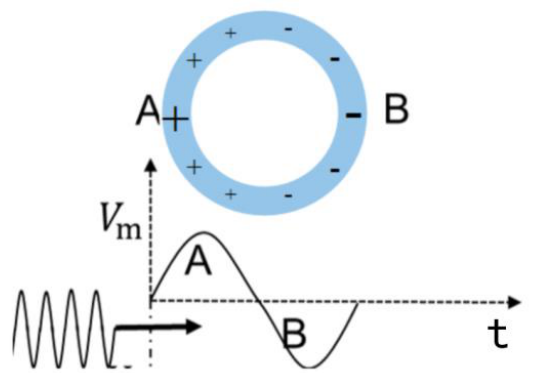
Figure 8. Zero modulation principle of uniform field. The blue area represents the microring, and the V m -t curve below represents the change of electric field intensity over time. Since f FSR = f RF , the time for the photon to travel one cycle in the ring is exactly equal to the time for one period of RF electric field. When the uniform electric field acts on the microring and the photon is transmitted in region A of the microring, the RF electric field is positive, and the corresponding results in Equation (3) is ∆ ϕ . Similarly, as the photon travels through the B region of the microring, the RF electric field reverses and the corresponding phase change is − ∆ ϕ . As a result, the overall phase difference of photons around the microring is zero.